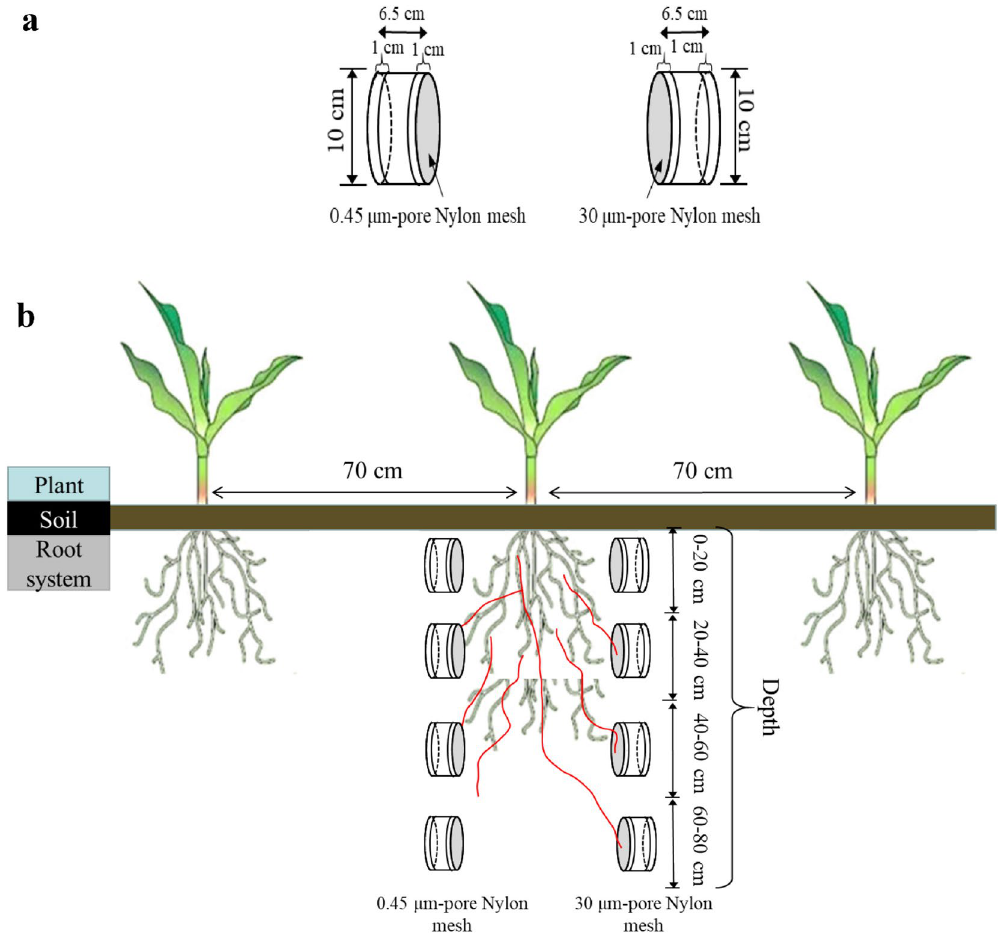
Figure 5. Schematic diagrams of the hyphal compartments ( a ) and the planting system ( b ) used in the experiment. Mycorrhizal hyphae are depicted in